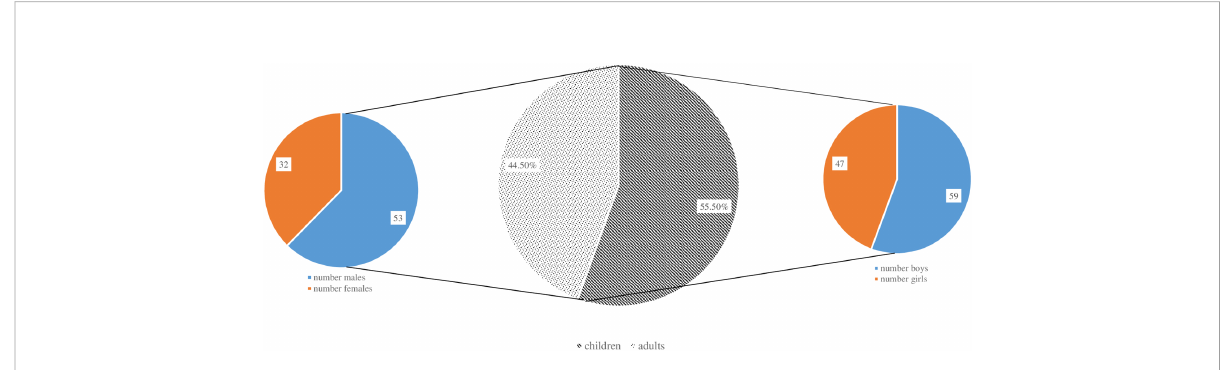
FIGURE 2 Distribution of patients in the National PID Expert Center by gender and age groups.